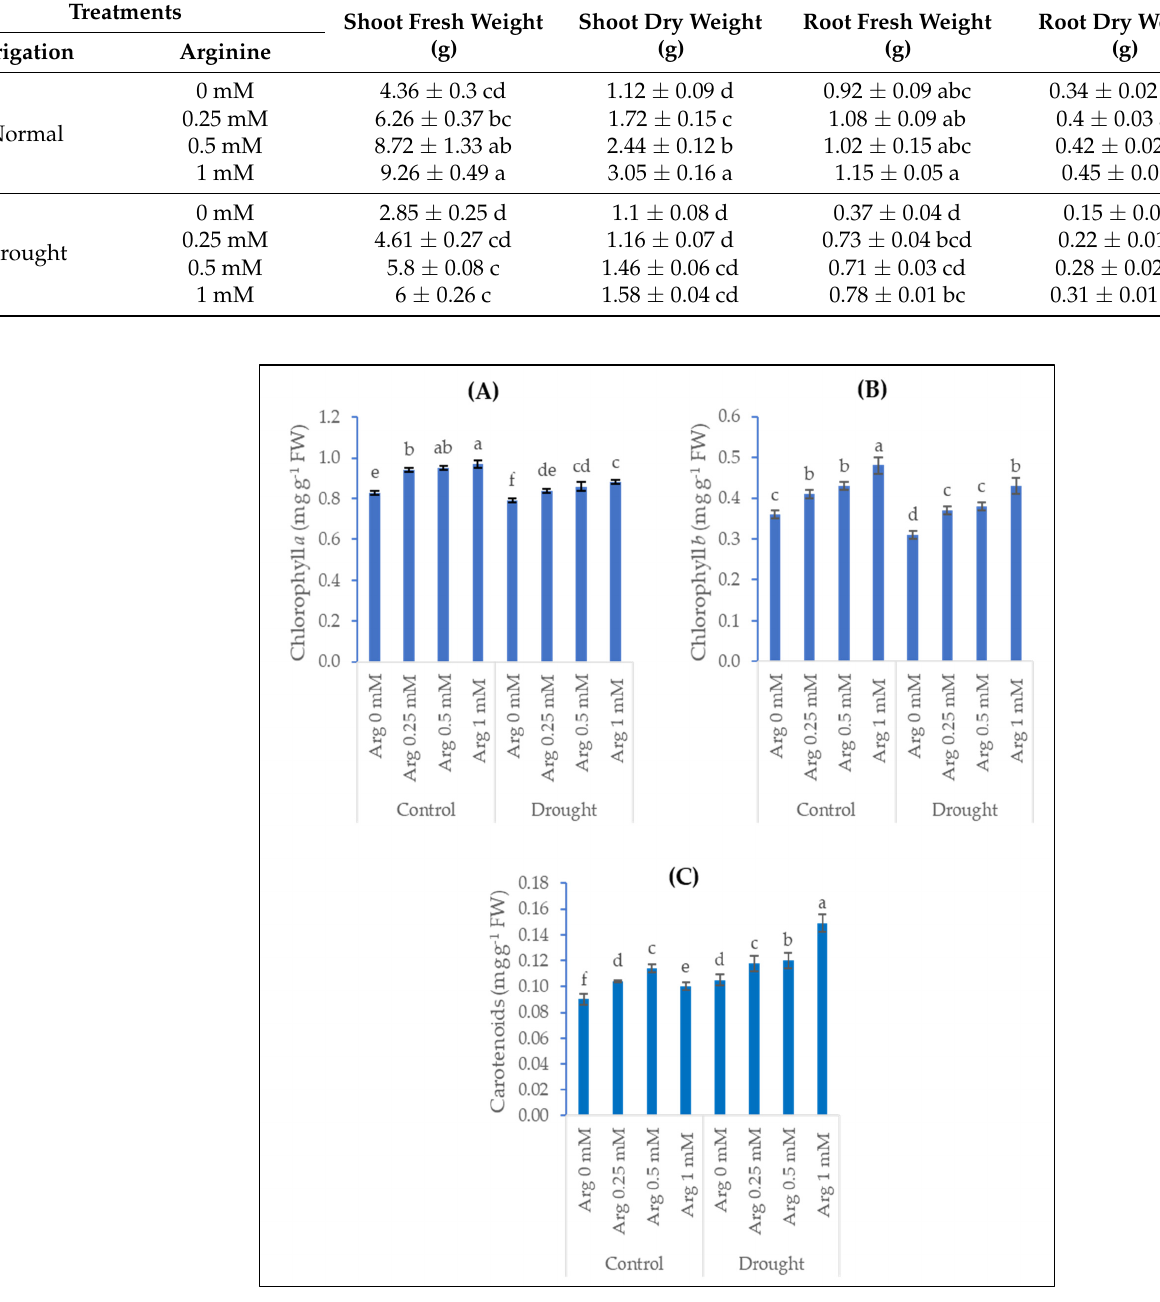
Figure 1. Effect of drought, arginine application, and their interactions on ( A ) chlorophyll a , ( B ) chlorophyll b , and ( C ) carotenoids contents of wheat plants. Each bar represents mean ± standard error. Means that do not share the same letter are significantly different. 2.3. Osmo-Protectants (Soluble Sugars, Free Amino Acids, Free Proline) Treating wheat plants with arginine (0.25, 0.5, and 1 mM) enhanced the content of soluble sugars, free amino acids, and proline compared to untreated plants (Figure 2). The highest content of sugars and amino acids was at the lowest level of arginine (0.25 mM). A gradual increase of arginine concentration enhances proline content, and the most sig- nificant was arginine 1 mM, which recorded an enhancement in proline content of about 70%. Exposure of wheat plants to drought conditions led to an insignificant increase in total soluble sugar content of about 36.57%. However, significant increases were recorded in the amino acids and proline by 4.89% and 41.26%, respectively, compared to unstressed plants. Furthermore, the application of arginine at 0.25, 0.5, and 1 mM caused nonsignifi- cant accumulations of soluble sugars, amino acids, and proline in drought-stressed wheat plants compared with the untreated plants, while only arginine at 0.25 mM significantly accumulated proline by 39.26%. It is worthy to note from Figure 2 that the low